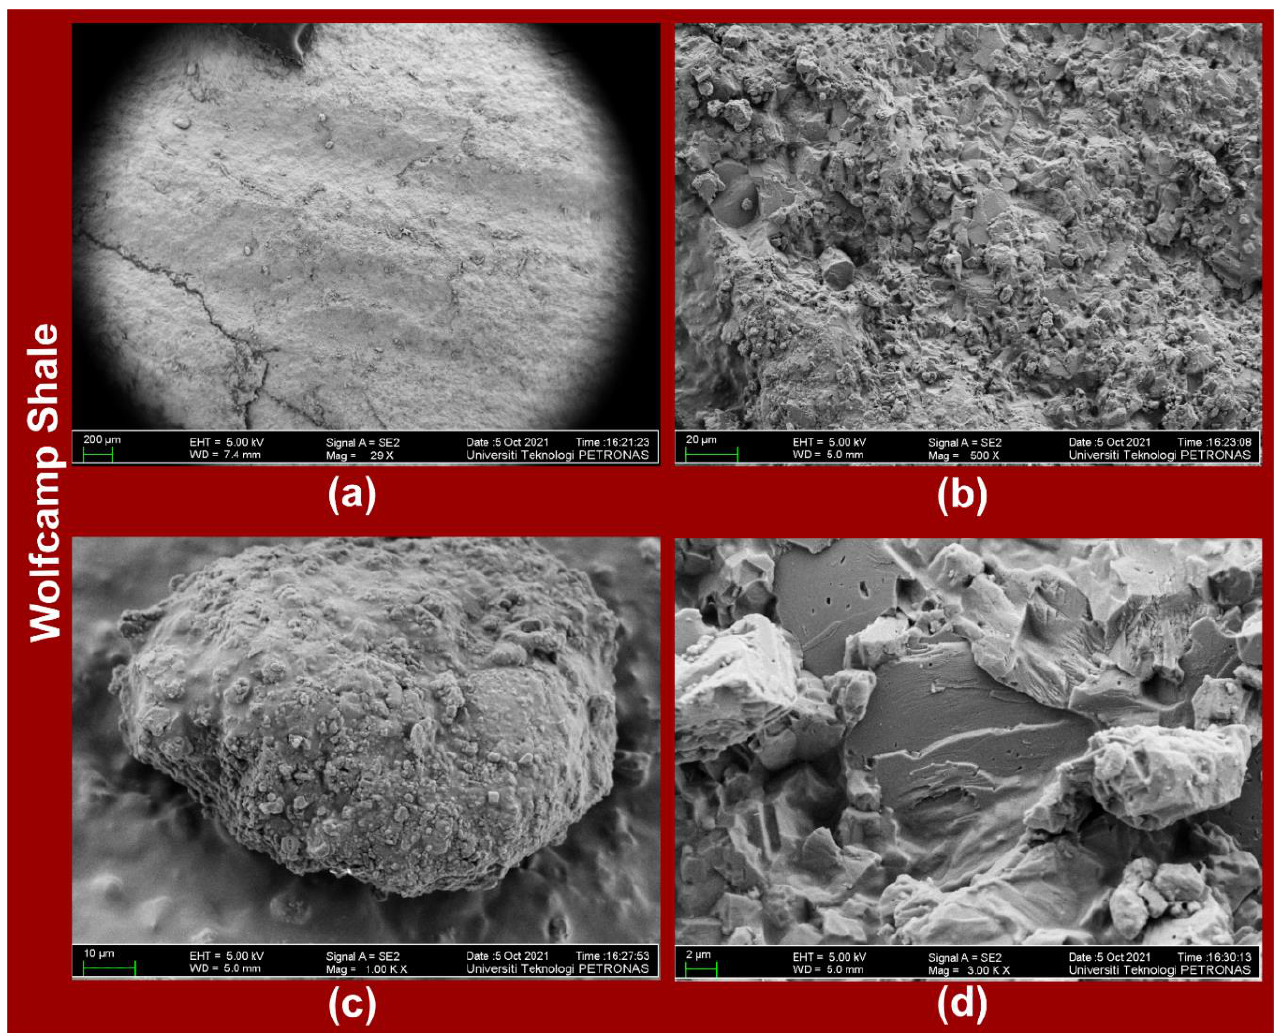
Figure 9. FESEM images of Wolfcamp shale at magnifications of ( a ) 29X, ( b ) 500X, ( c ) 1000X, and ( d ) 3000X.